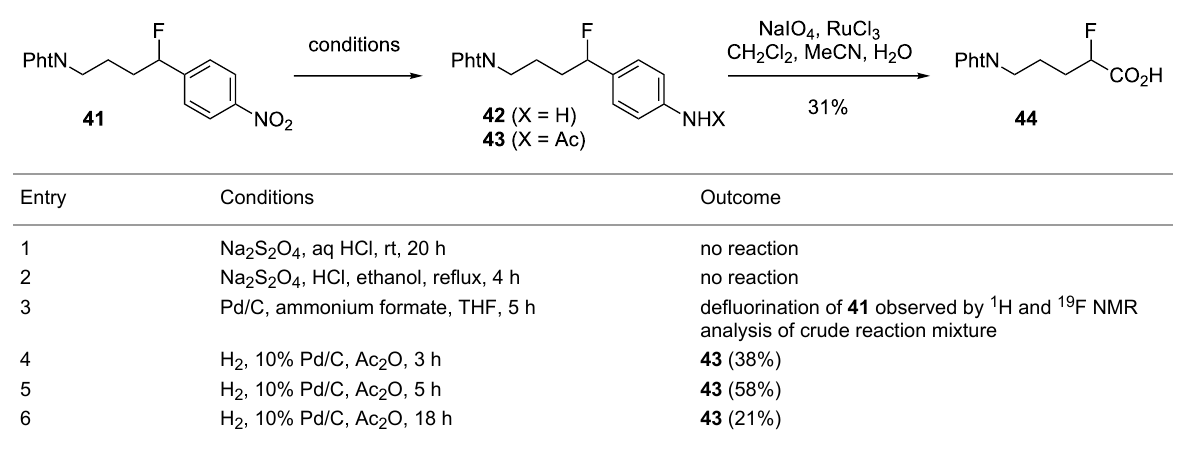
distilled acetic anhydride and subjected to hydrogenation over Pd/C (Scheme 4). The reaction was monitored by TLC at short time intervals in order to avoid over-reduction. The starting ma- terial was consumed within 5 h, but the expected acetanilide product (see Supporting Information File 1) was accompanied by varying quantities of a side-product that was tentatively identified either as an alternative rotamer of the acetanilide, or the corresponding imide (i.e., ArNAc 2 , see Supporting Informa- tion File 1). Although the formation of this imide would be unexpected, it was reasoned that it might still be a suitable sub- strate for the subsequent oxidation reaction. Accordingly, the product of the hydrogenation reaction was next treated with so- dium metaperiodate and ruthenium trichloride (Scheme 4), and gratifyingly this delivered the desired trifluorinated carboxylic acid (see Supporting Information File 1) in moderate